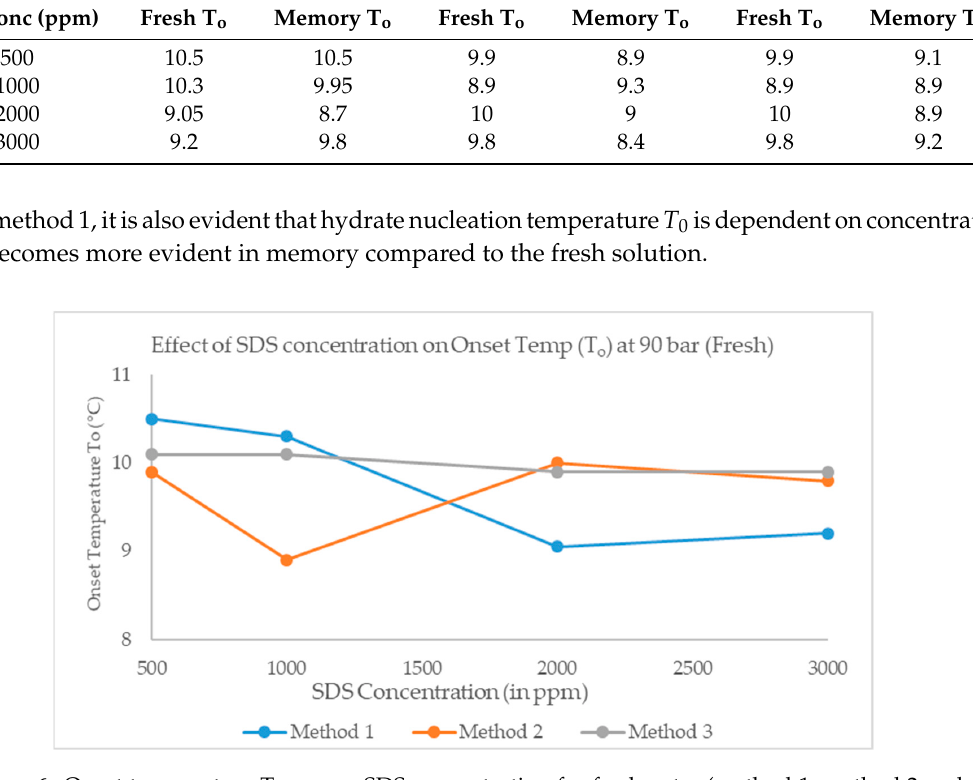
Table 2. Onset temperature T o (°C) at 90 bar pressure and different sample volume and rocking angle.